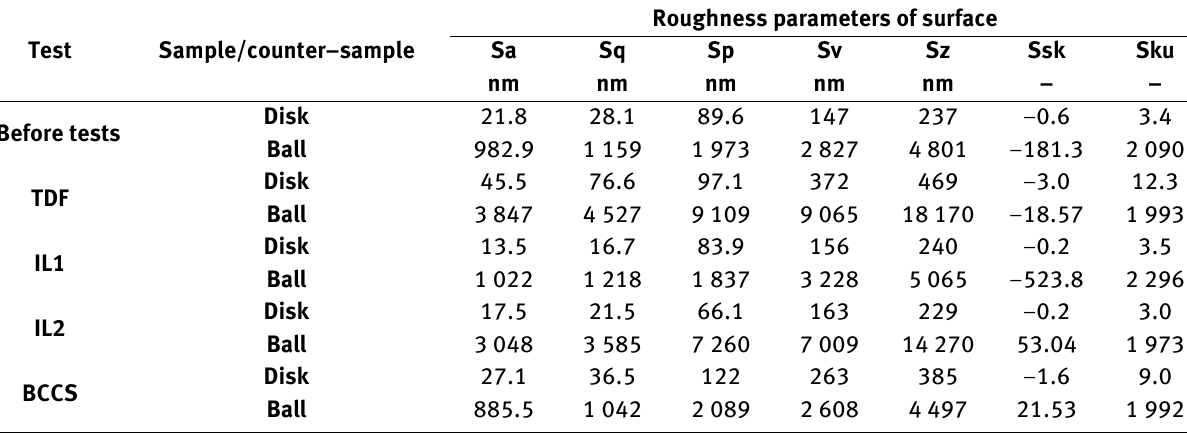
Table 4: Roughness parameters discs before and after tribological tests.